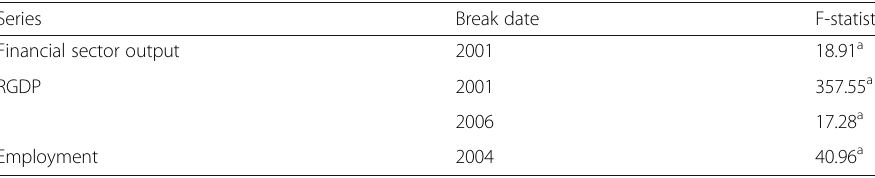
Table 1 Chow Structural Break test